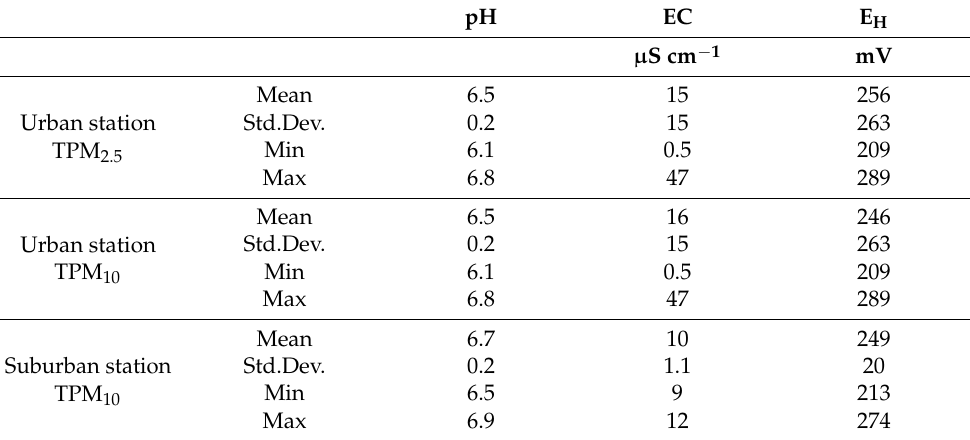
Table 2. Chemical–physical parameters measured in the leaching filters. EC: electrical conductivity ( µ S/cm), E H (mV).